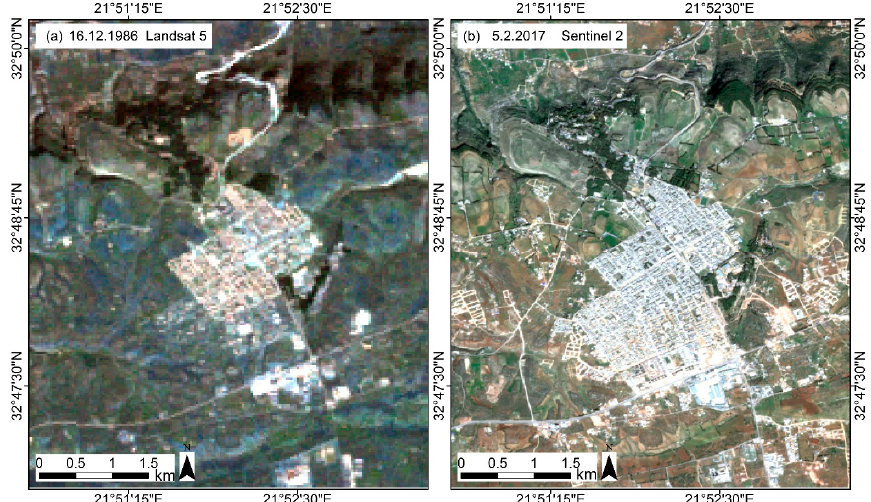
Figure 8. Shahat has expanded significantly in size since 1986. ( a ) A landsat 5 TM image (USGS) 16 December 1986; ( b ) A Sentinel-2 image (ESA), 5 February 2017.